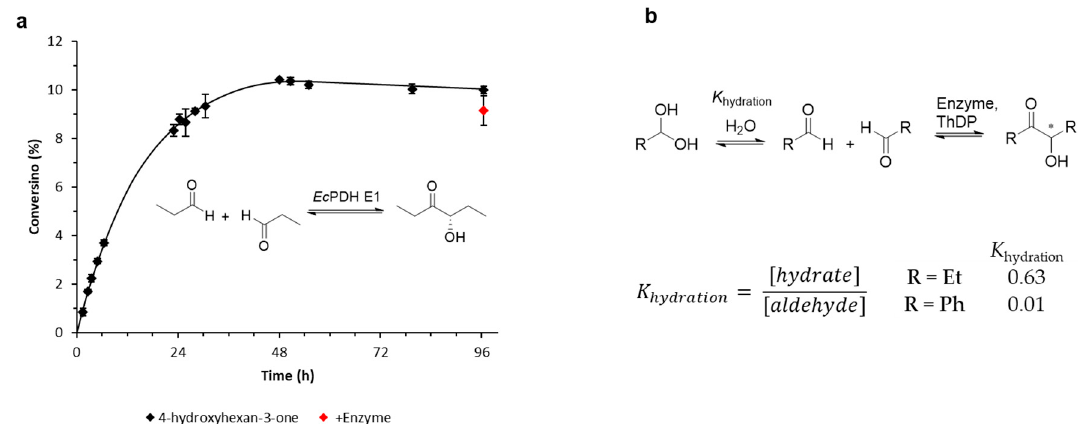
Figure 4. ( a ) Time course of the Ec PDH E1 catalysed self-reaction of propionaldehyde (2 mg / mL Ec PDH E1, 0.2 mM ThDP, 2 mM MgCl 2 , 50 mM propionaldehyde, 20 mM KPi, pH 7.5). The position of the thermodynamic equilibrium limits the reaction to 10% conversion under given experimental conditions. ( b ) The hydration of aldehydes in aqueous solution introduces a competing equilibrium reaction. Electrophilic aldehydes display a large hydration constant [56], which renders the target reaction thermodynamically less favourable.